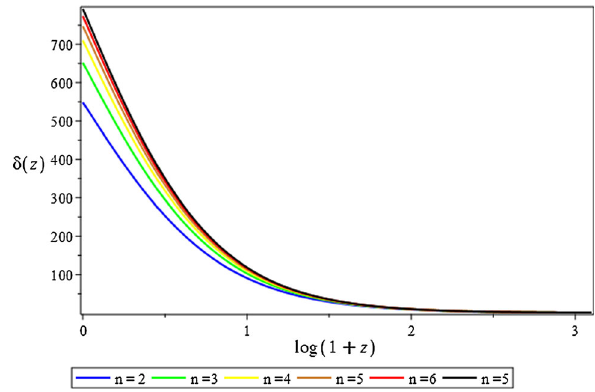
Fig. 4 δ( z ) versus z for Eq. (100) in the torsion-dust system for n is closer to 0 . 5